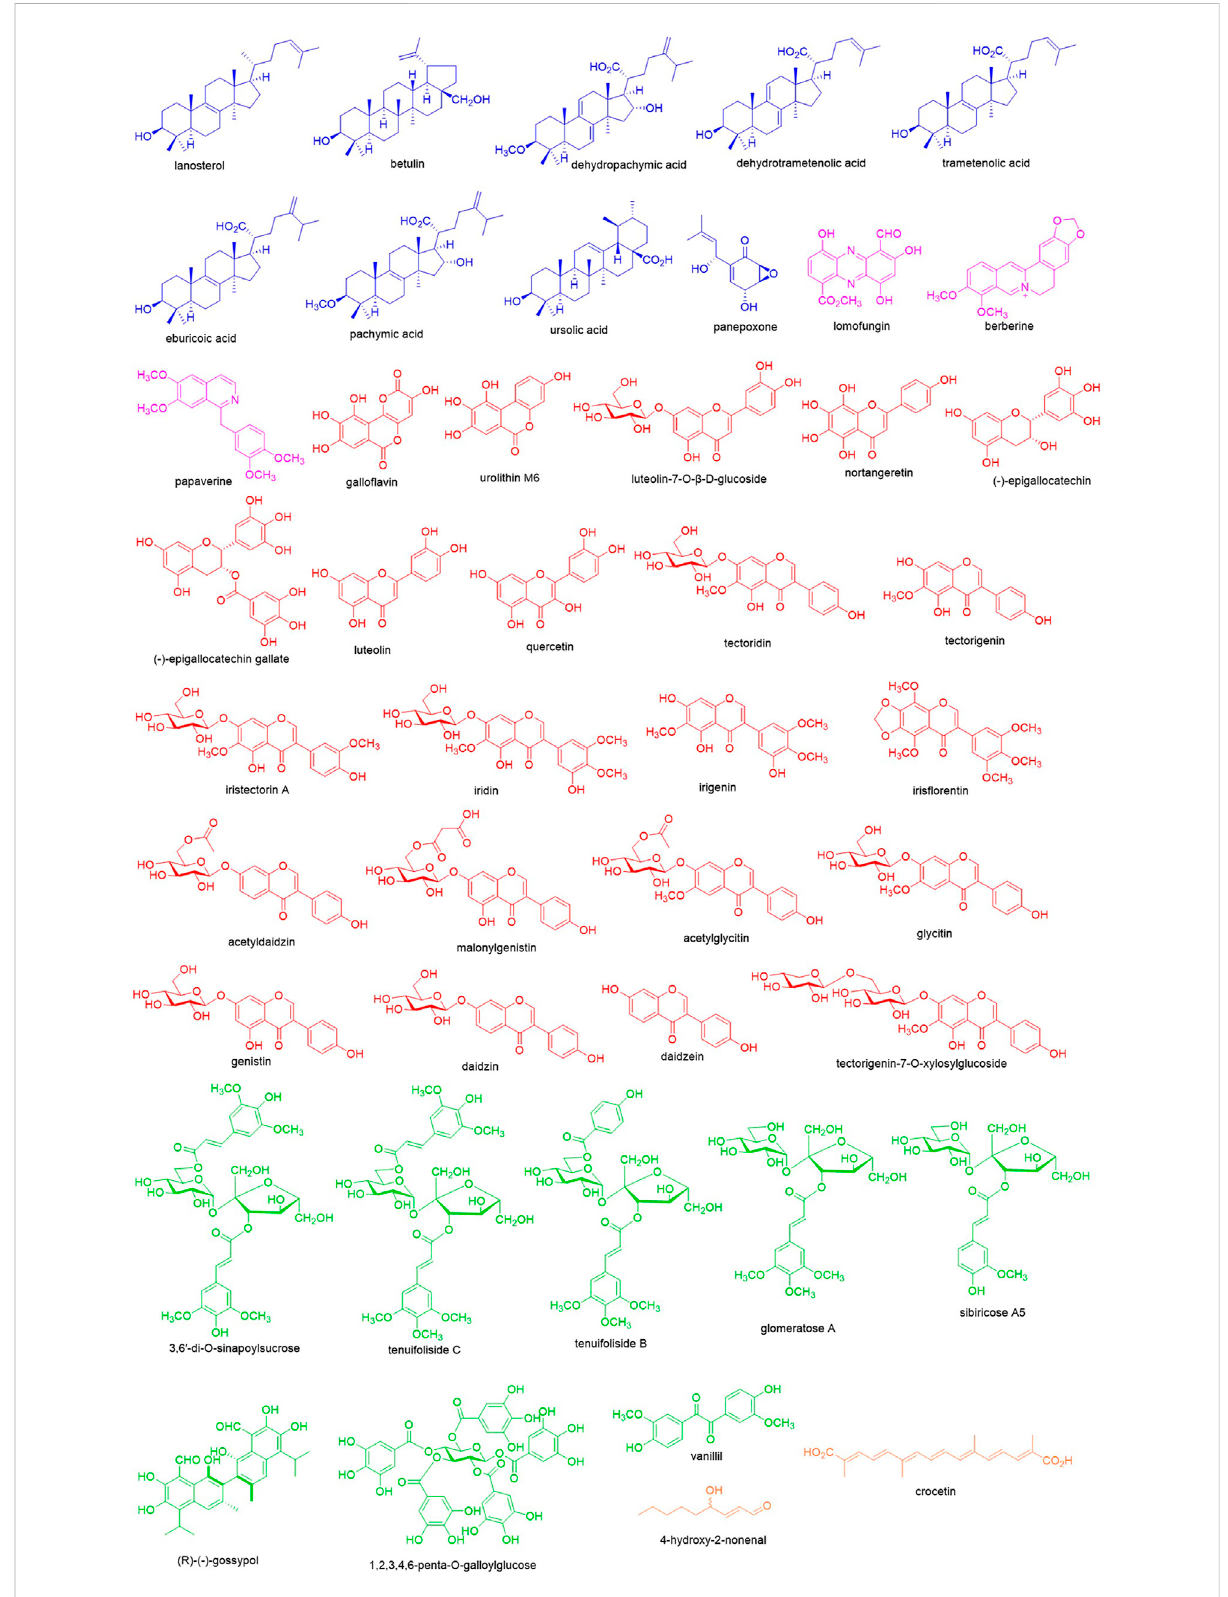
FIGURE 2 Natural products with potential inhibition of